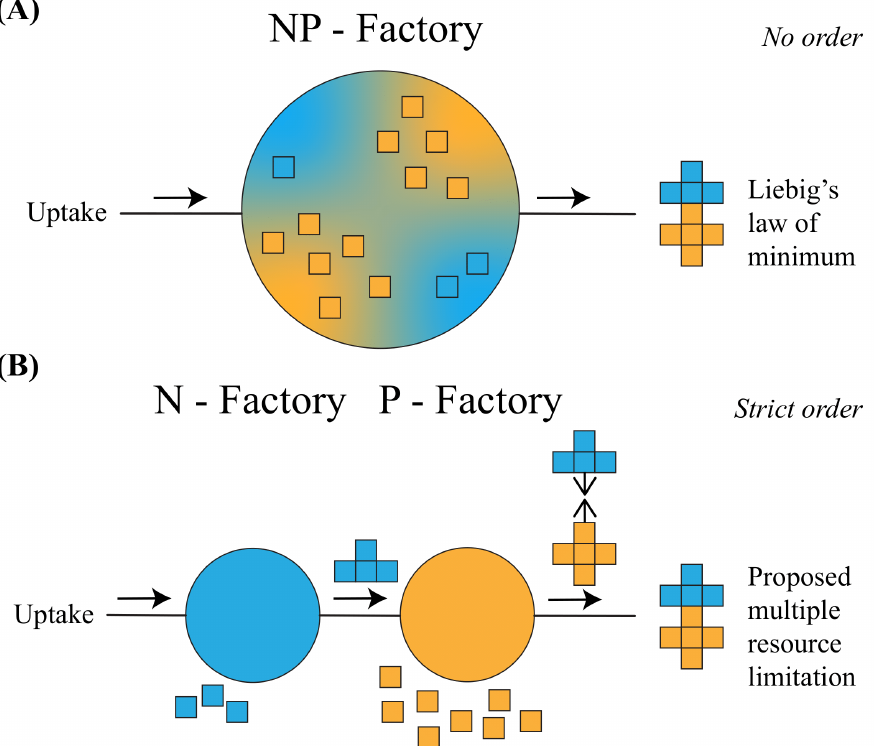
Figure 2. An analogy for Liebig’s law of the minimum and the proposed multiple resource limitation. ( A ) An NP -factory that concurrently processes both N and P to make the final product as an analogy to Liebig’s law of the minimum. The production rate of the final product is constrained by the slowest rate of making sub-parts from N or P . ( B ) Two resource-specific ones ( N -factory and P -factory) in a strict production chain as an analogy to the proposed multiple resource limitation. The time to make a final product is then the combined time to make N - and P -sub-parts. Note that there is no order of production in A, but a strict order of production in